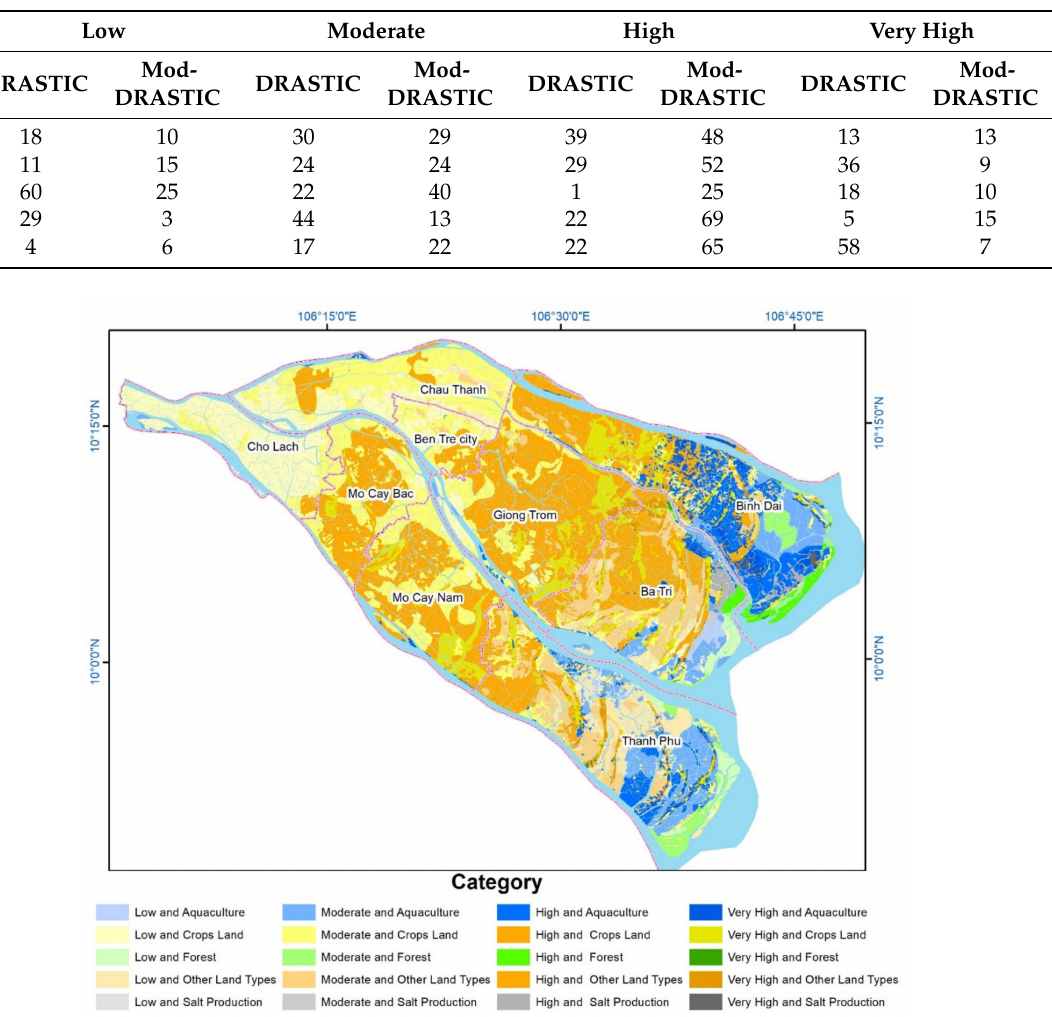
Figure 6. The Mod-DRASTIC vulnerability categories and land use